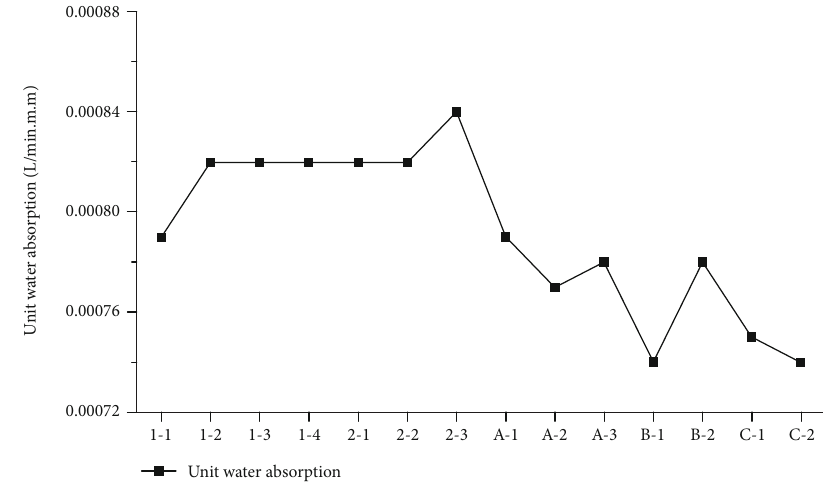
Figure 11: Results of water pressure